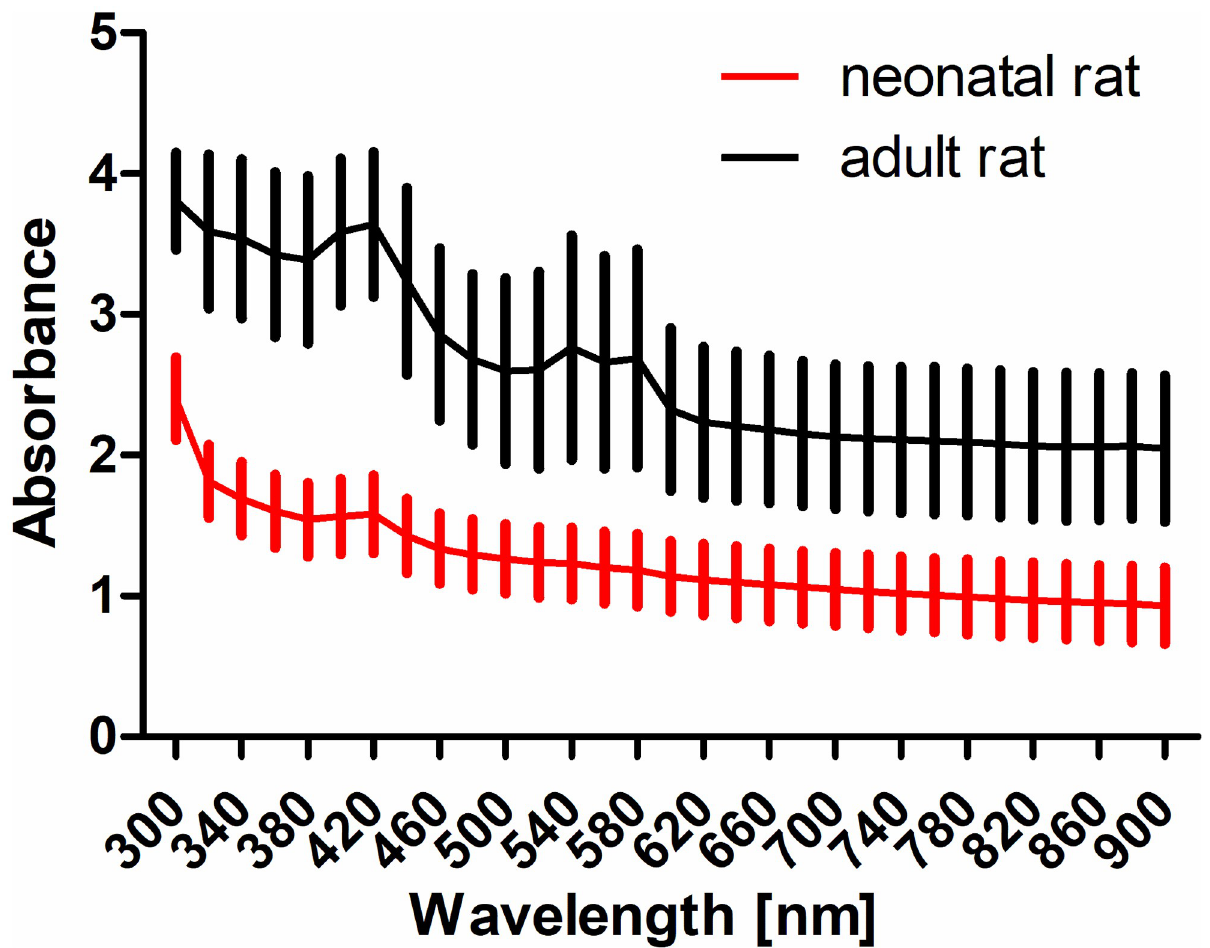
Fig 7. Absorbance of TM from neonatal and adult rats. All TM were measured from 300 nm to 900 nm in area scan mode. Presented are mean values ± standard